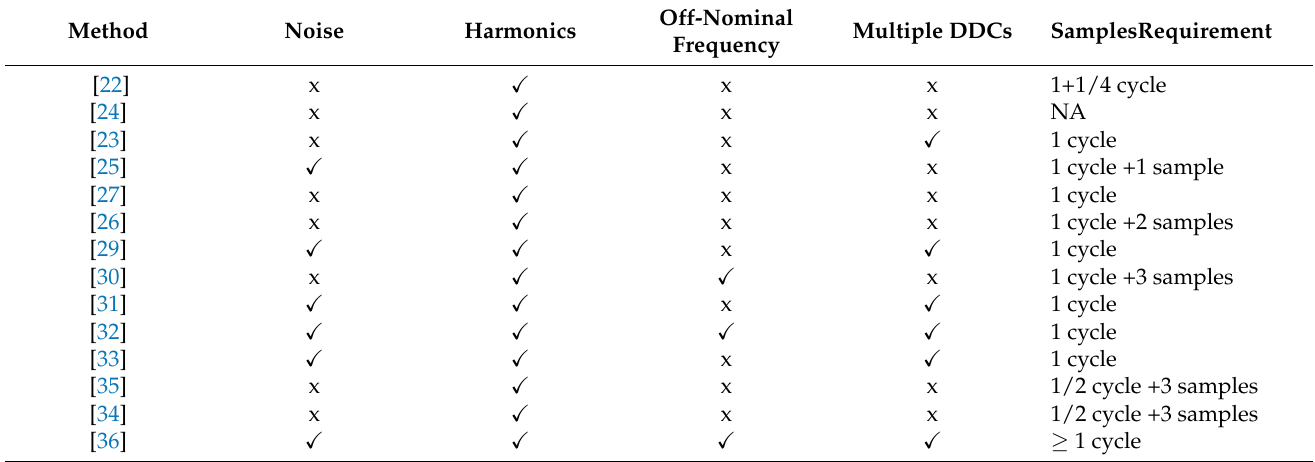
Table 3. Post-DFT DDC mitigation methods comparative analysis in the presence of destructive factors.